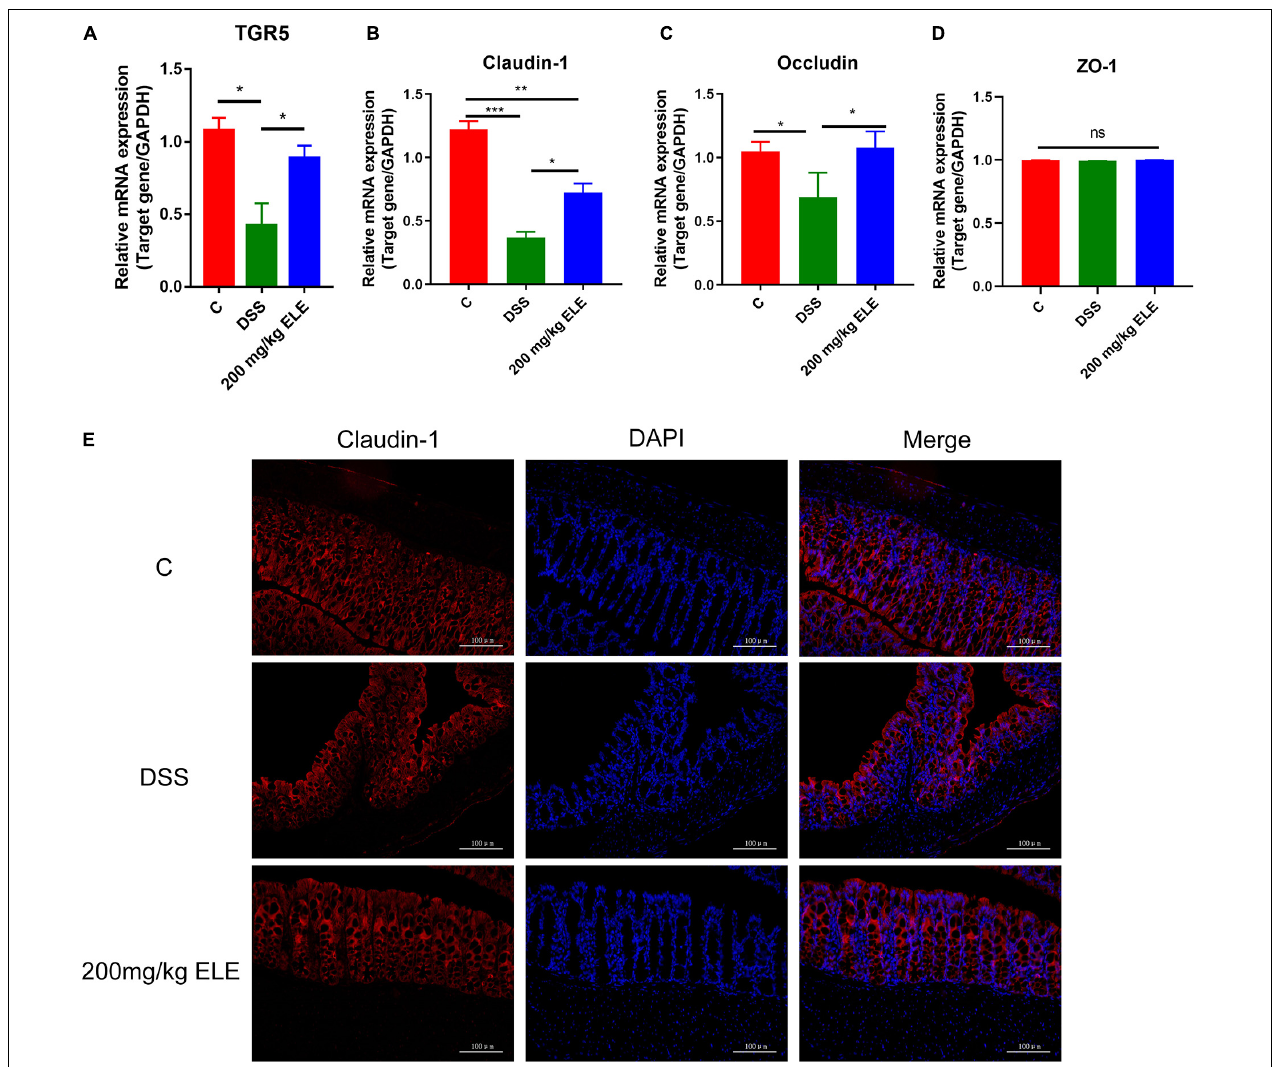
FIGURE 5 | Oral ELE improves DSS-induced decrease of TGR5 and tight junction expression in colon. (A – D) mRNA expression level of TGR5, claudin-1, occludin, and ZO-1, n = 7–8 mice/group. (E) Representative image of tissue immunofluorescence of claudin-1, n = 3 mice/group. Differences in data in mouse subjects were assessed by one-way ANOVA. * p < 0.05; ** p < 0.01; *** p <